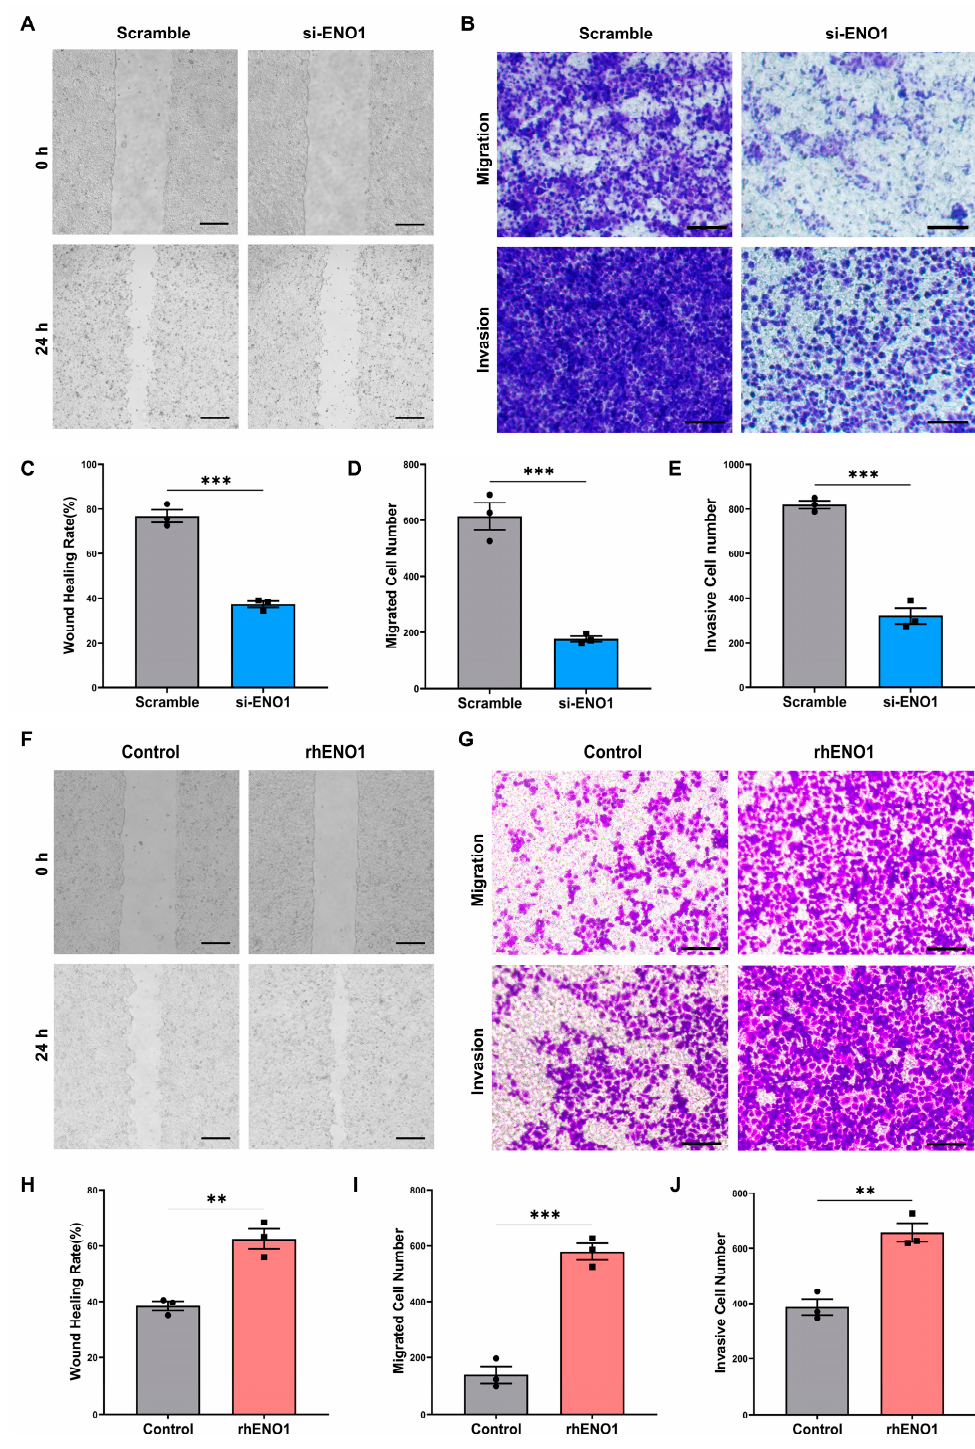
Figure 2. ENO1 promotes tumor cell migration and invasion through macrophages. ( A , C ) Wound- healing assay of CAL27 cells incubated with Macro-CM from macrophages induced by TCM of transfected CAL27 cells. ( A ) representative pictures; ( C ) bar charts indicating the wound healing rate. Magnification 40×. Scale bar: 500 μ m. ( B , D , E ) Transwell assay for migration (upper panel) and invasion (lower panel) of CAL27 cells cocultured with macrophages induced by TCM of transfected CAL27 cells. ( B ) representative pictures; ( D , E ) bar charts indicating the cell numbers of migrated or invasive cells per area. Magnification 200×. Scale bar: 100 μ m. ( F , H ) Wound-healing assay of CAL27 cells incubated with Macro-CM from macrophages induced by TCM without or with rhENO1. ( F ) representative pictures; ( H ) bar charts indicating the wound healing rate.